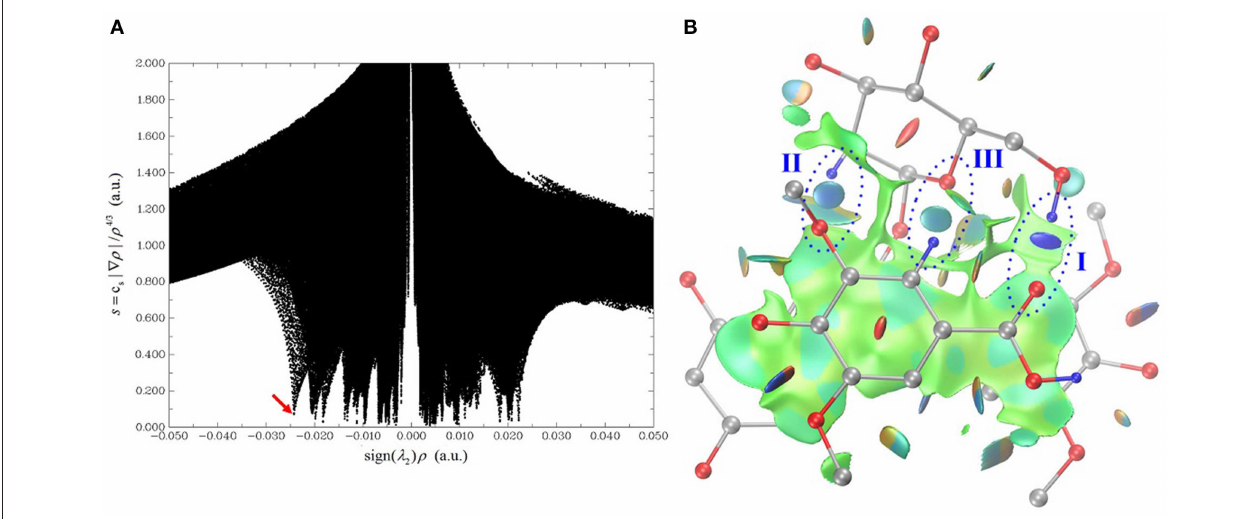
FIGURE 3 | Visualization of non-covalent interactions in complex 1 . (A) is a plot of the reduced density gradient vs. the electron density multiplied by the sign of the second Hessian eigenvalue. (B) is the gradient isosurface ( s = 0.5au), which is colored on a blue-green-red scale according to values of sign( λ 2 ) ρ , ranging from − 0.02 to 0.02au. Blue indicates strong attractive interactions, and green indicates weak interactions, and red indicates strong non-bonded overlap.